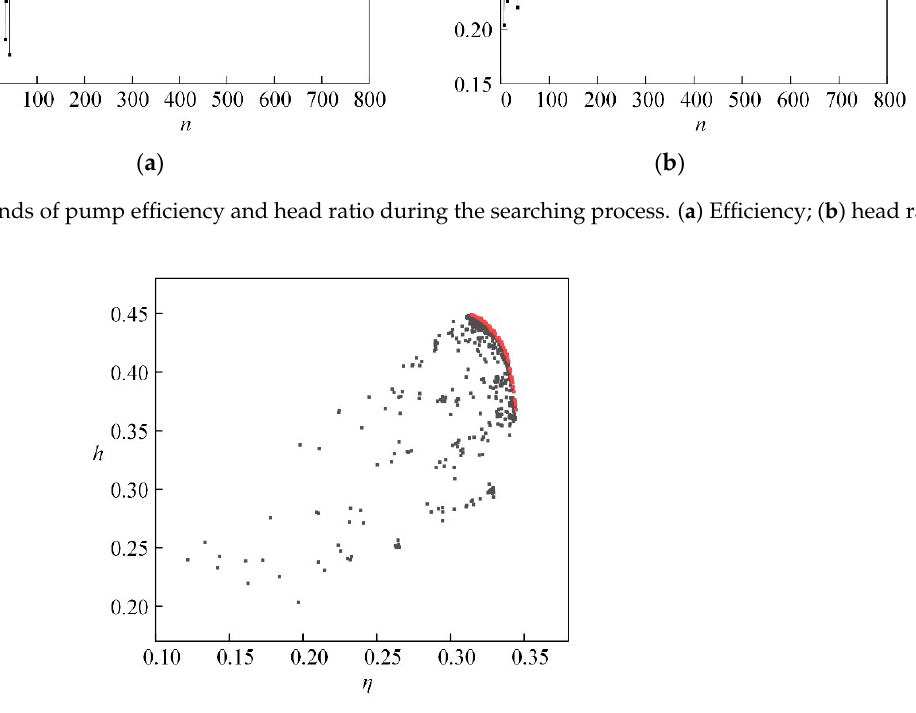
Figure 10. Trends of pump efficiency and head ratio during the searching process. ( a ) Efficiency; ( b ) head ratio. Using the NSGA-II algorithm, the non-dominated solutions are obtained and the Pa-